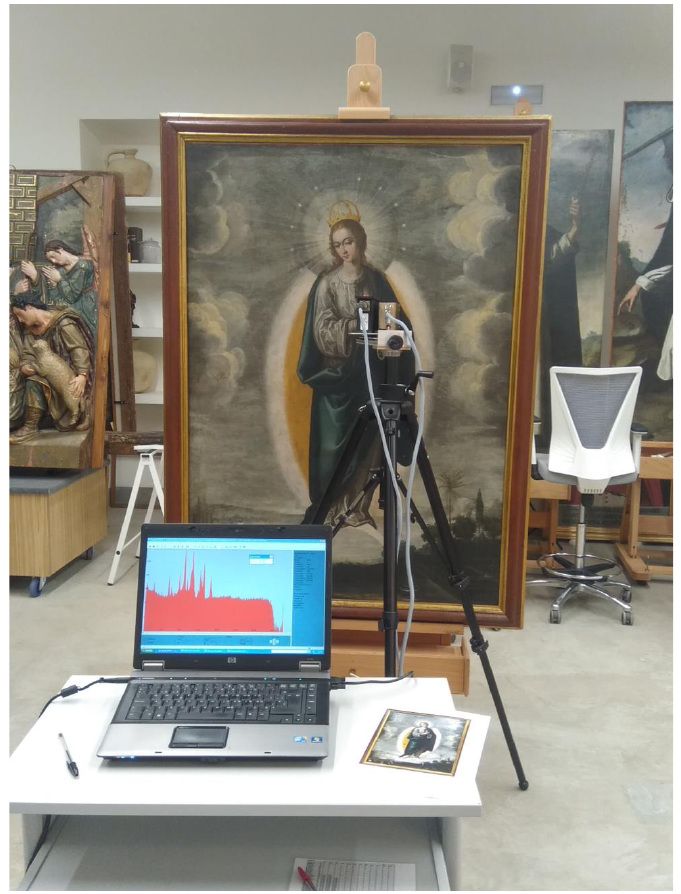
Figure 2. XRF in situ analysis of La Inmaculada